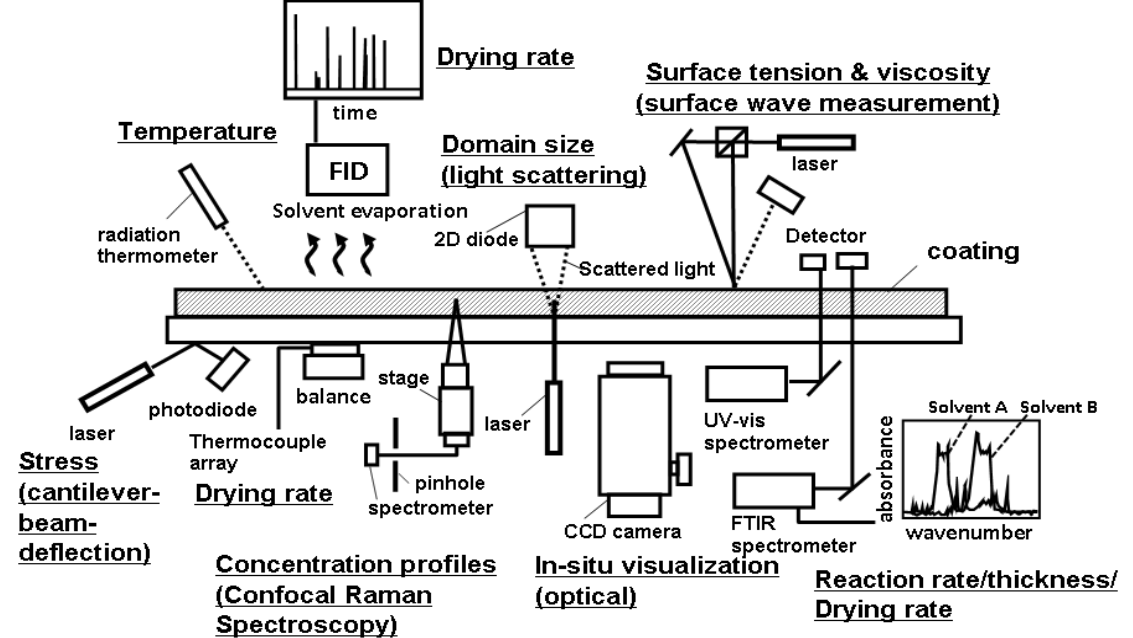
Fig. 7 Integrated in-situ measurement devices for evaporating thin complex